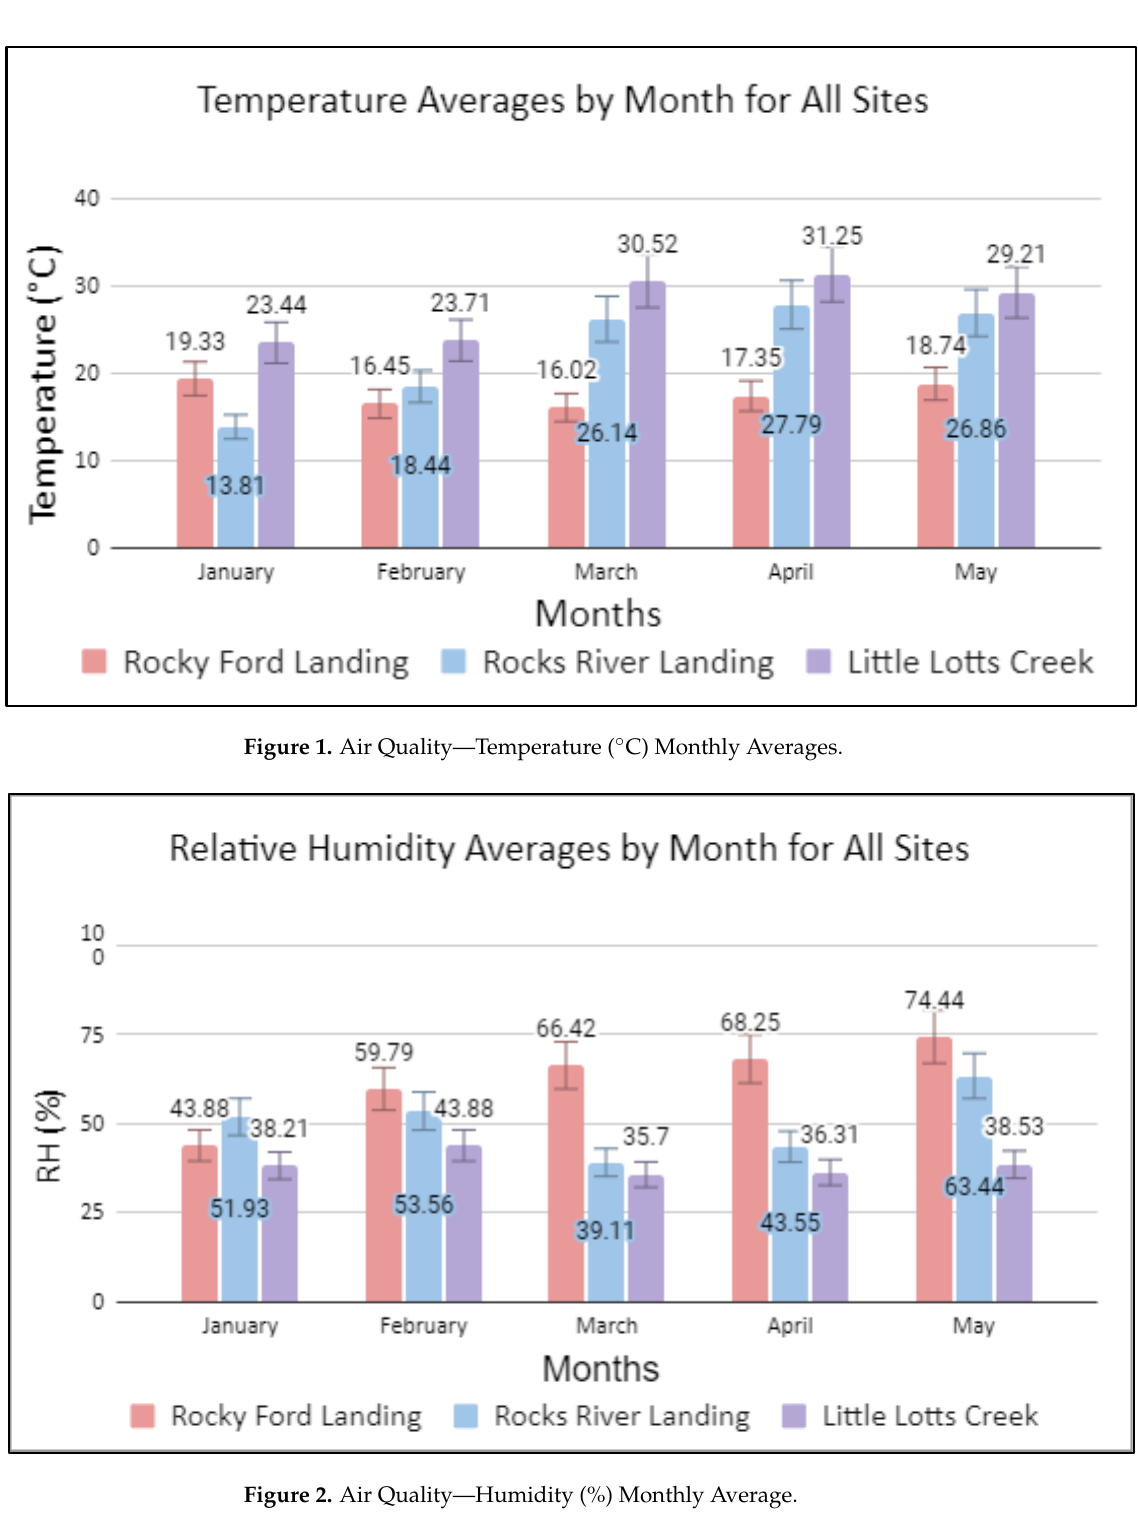
Figure 2. Air Quality — Humidity (%) Monthly Average.